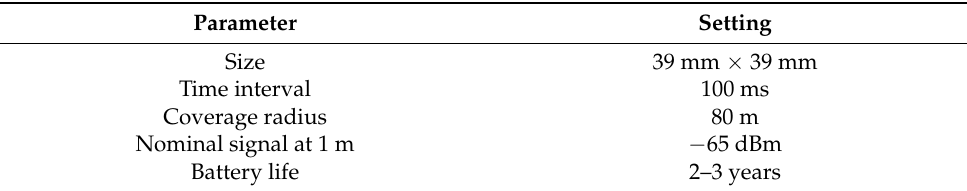
Table 2. iBeacon base station